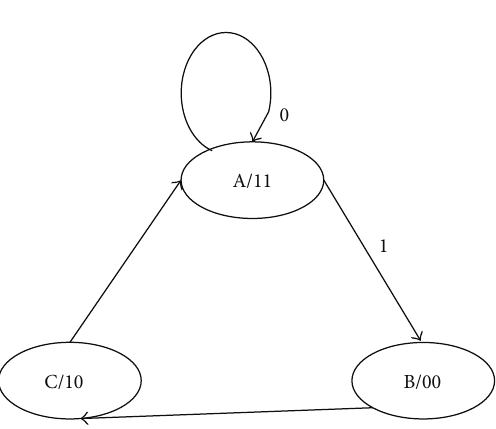
Figure 5: State diagram of